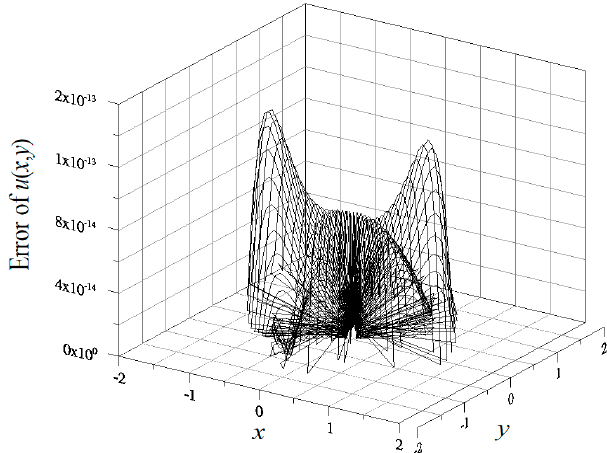
Figure 5. The numerical errors of the proposed method solution for the steady-state AC equation with Cassini-shaped domain.